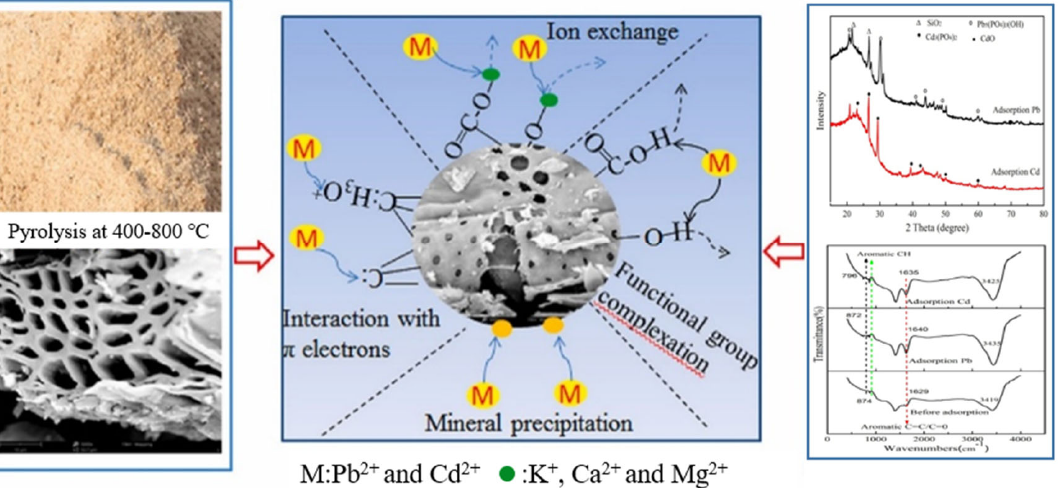
Figure 11. Cd and Pb adsorption removal from wastewater by biochar derived from poplar saw, [107], with permission from Elsevier, 2021